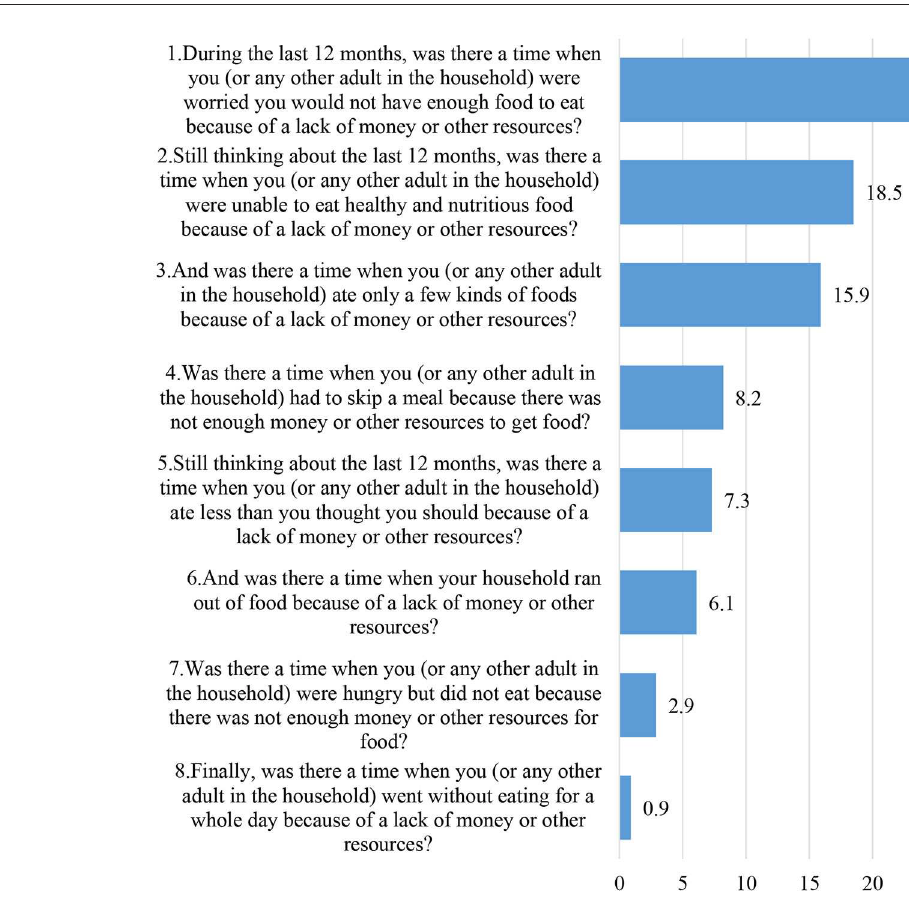
job), government employee, company-hired worker, business owner, wage laborer, and farmer.